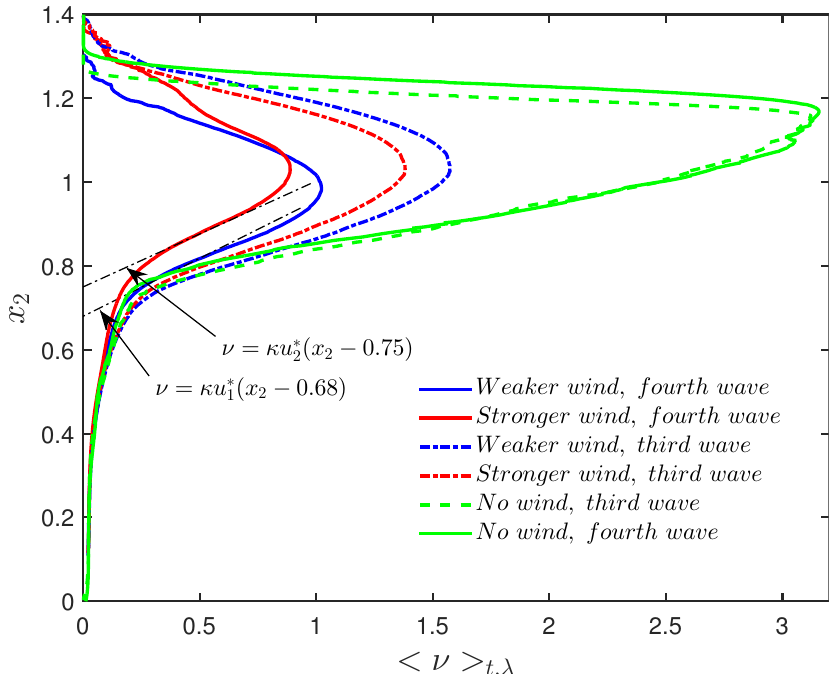
Figure 5. Wall-normal profiles ( x 2 [m]) of streamwise and wave-length averaged eddy viscosity [kg/ms] for the third waves (dashed-dotted lines) and the fourth waves (solid lines) and the case with the stronger wind body force f = 0.6 [N/M] (colored in red) and the case with weaker wind body force f = 0.5 [N/M] (colored in red). Green dashed lines correspond to the case with regular waves with no wind and black dashed-dotted lines correspond to theoretical values of eddy